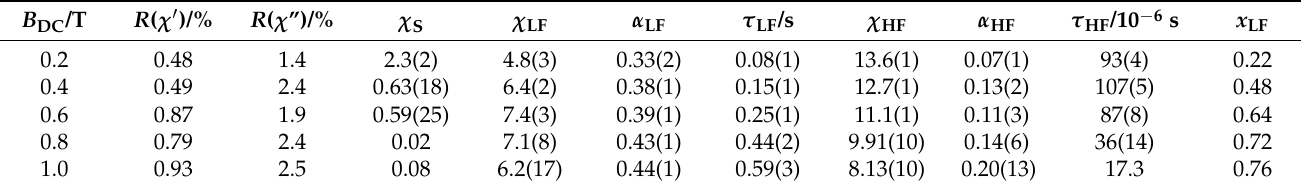
Table 3. Field dependence of AC susceptibility parameters for 1 at T = 2.0 K.